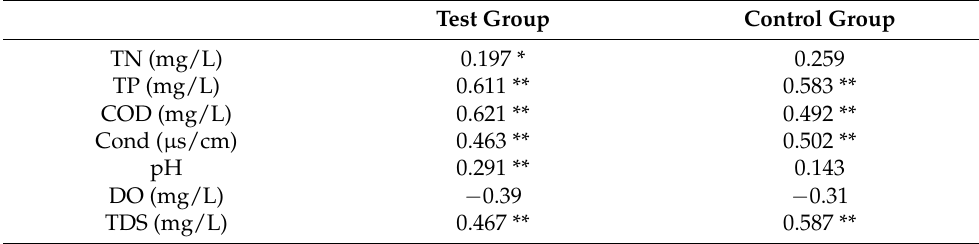
Table 4. Pearson’s correlation coefficients between the CDI index and environmental variables (test group: 83 samples; control group: 33